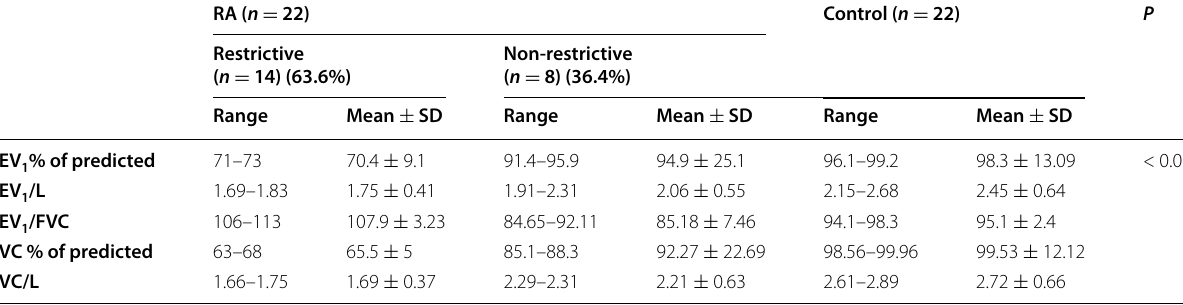
Table 5 Results of spirometry parameters in rheumatoid arthritis patients and control